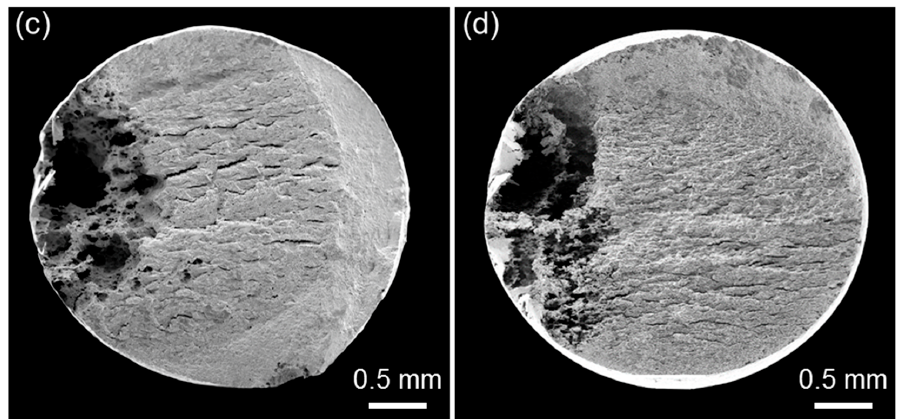
Figure 9. SEM micrographs of the fractured surfaces of ( a , b ) D1 and ( c , d ) D2 alloys after the SSRT conducted in 2 M NaCl solution at 50 °C under anodic applied potential of +0.05 V versus E corr at a strain rate of 10 − 6 s − 1 . The SSRTs were conducted along ( a , c ) L- and ( b , d ) T-directions.